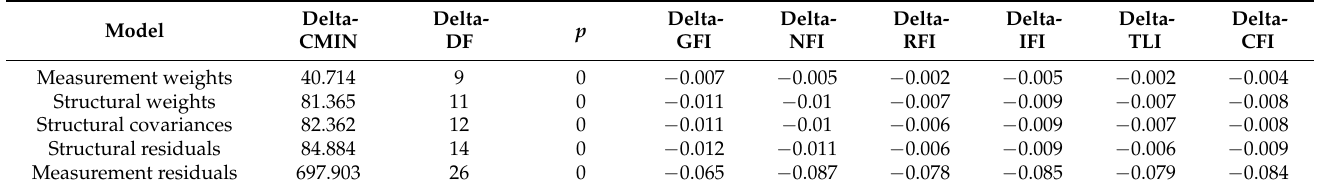
Table 9. Invariant analysis.